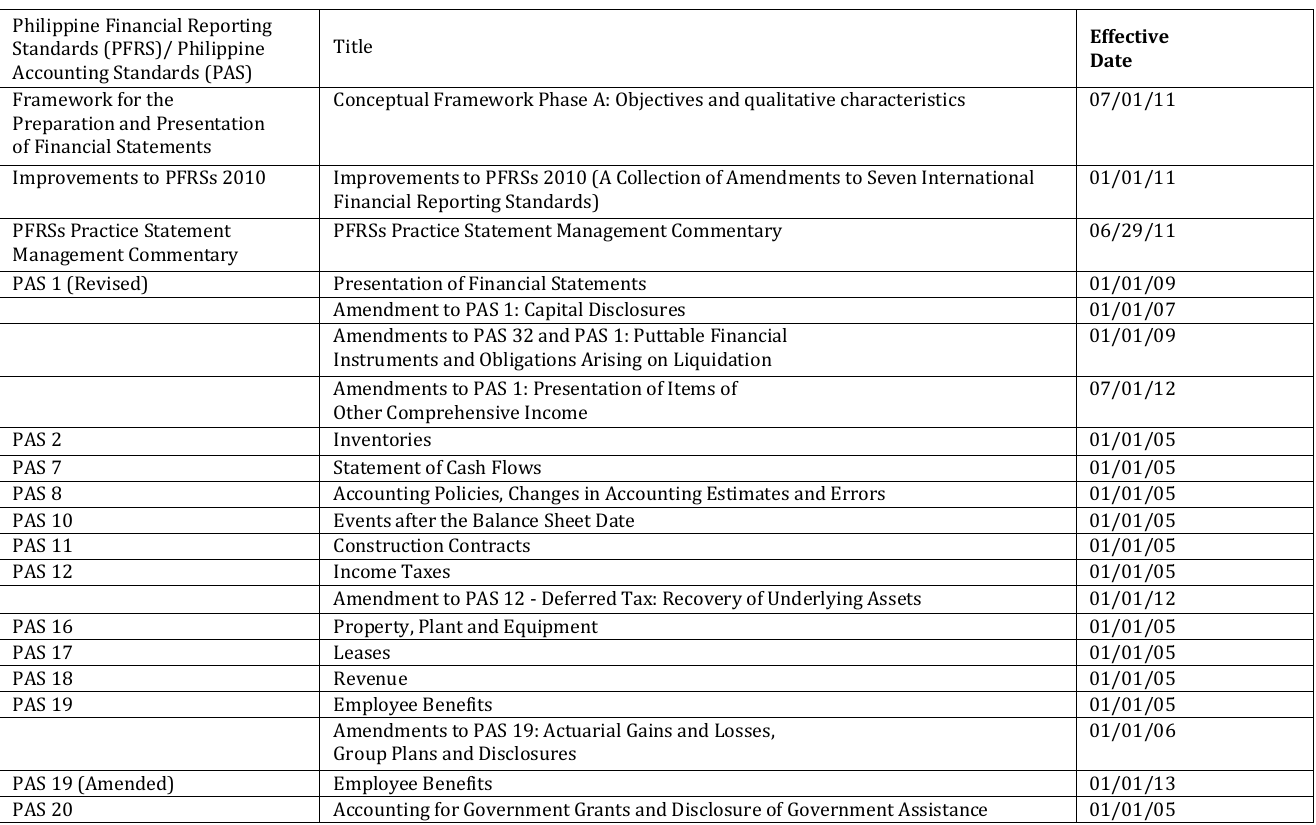
TABLE 1 : Philippine Financial Reporting Standards (adopted by SEC as of December 31, 2011) Philippine Financial Reporting Standards (PFRS)/ Philippine Accounting Standards